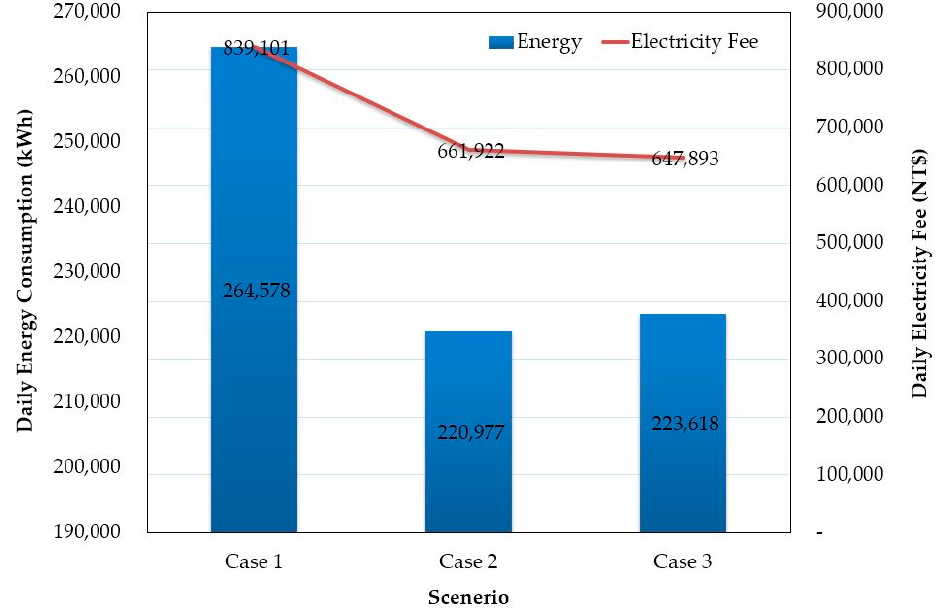
Figure 24. Comparison of the energy consumption and electricity fee for each scenario.